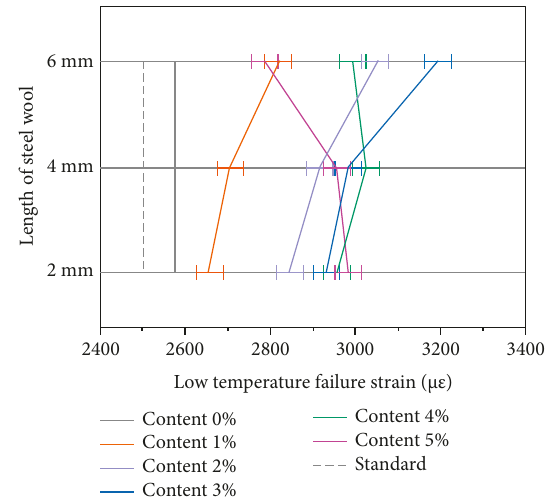
Figure 3: Low-temperature performance of steel wool asphalt